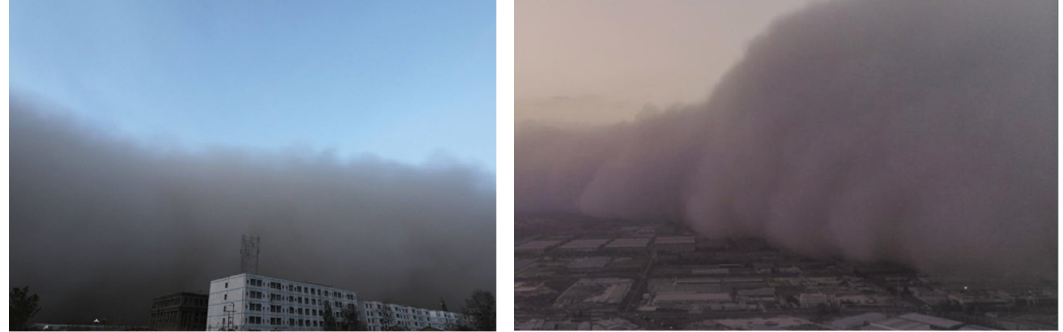
Figure 1. The front of a local strong sandstorm (LSS) occurred in Alar City, China on 6 April 2019 [11].